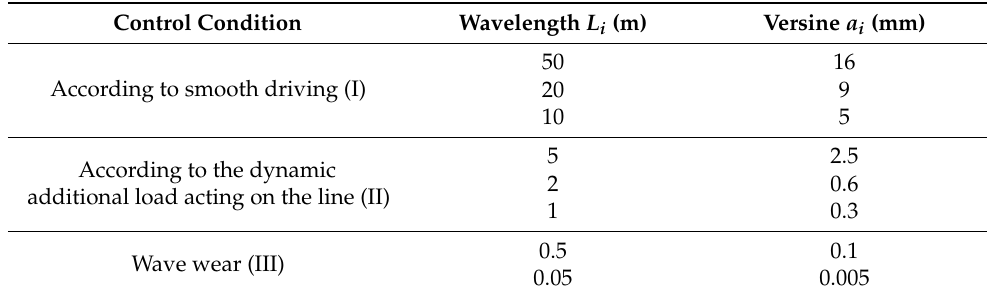
Table 1. Track geometry for uneven management of classical